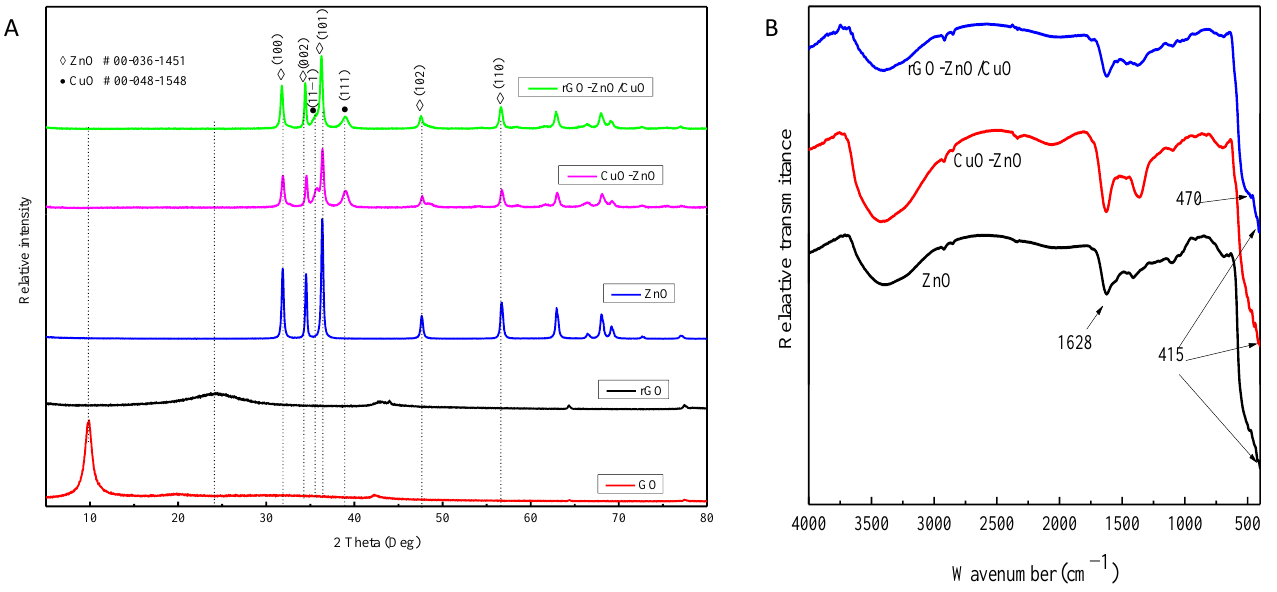
Figure 1. ( A ) XRD patterns of GO, rGO, ZnO, CuO-ZnO, and (rGO-ZnO)/CuO samples; ( B ) FTIR spectra of ZnO, CuO-ZnO, and (rGO-ZnO)/CuO samples.